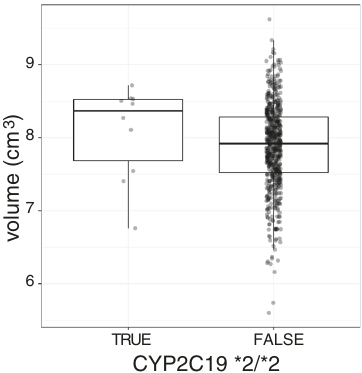
Fig. 1 Boxplots of estimated hippocampal volumes, after adjust- ment for subcortical volume, sex, age, and site. The position of the observations on the x -axis was jittered to improve